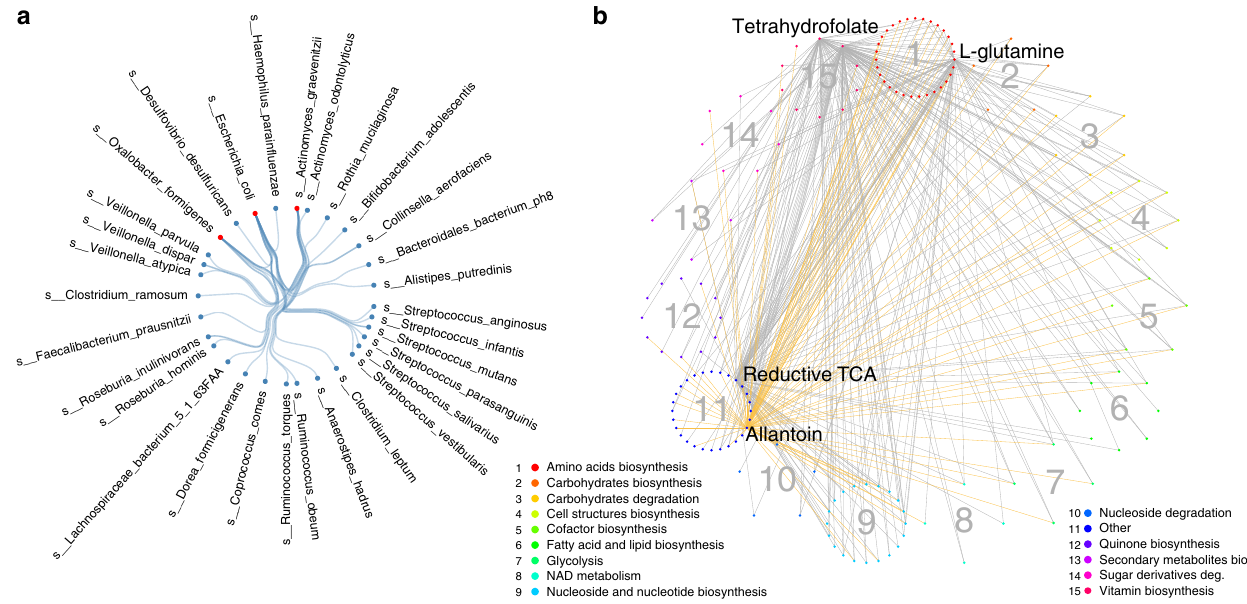
Fig. 4 Cohort-speci fi c species and pathway co-abundances. a Cohort-speci fi c co-abundances identi fi ed for three key species in the IBD cohort, involving 33 IBD-speci fi c co-abundances. Each dot indicates one species. Red indicates IBD key species. Each line represents one IBD-speci fi c co-abundance relationship. b Cohort-speci fi c co-abundances identi fi ed for four key pathways in IBD and one key pathway in 300OB, involving 385 cohort-speci fi c co- abundances. Each line represents a cohort-speci fi c correlation between two pathways. Yellow lines represent obesity-speci fi c co-abundances. Grey lines represent IBD-speci fi c co-abundances. Each dot indicates one pathway. Pathways belonging to the same metabolic category have the same colour and are clustered as sub-circles. Colour legends are shown in the